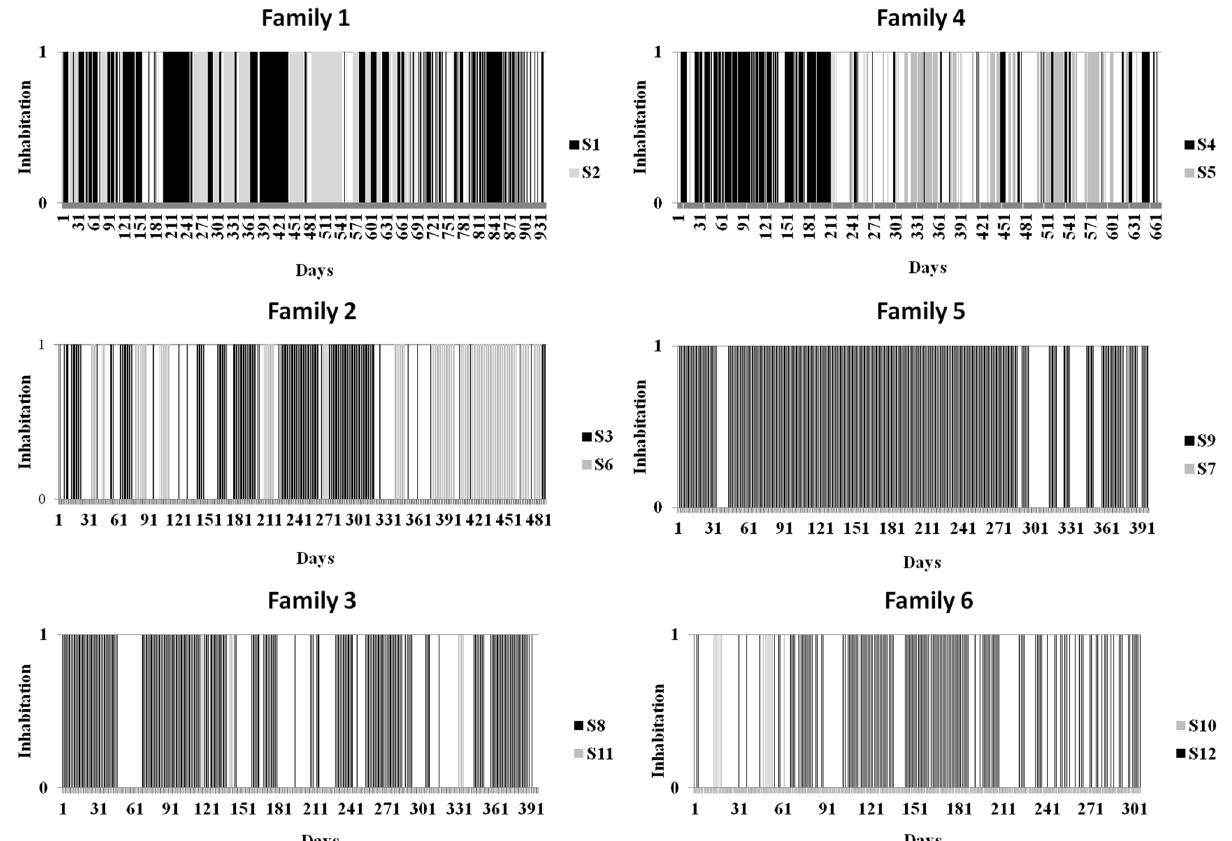
Figure 1. Inhabitation pattern of each porcupine family in the two inhabited settlements (black and grey coloured) during the whole monitoring period. Black colour always refers to the main inhabited settlement. White spaces indicate the days in which it was not possible to assess